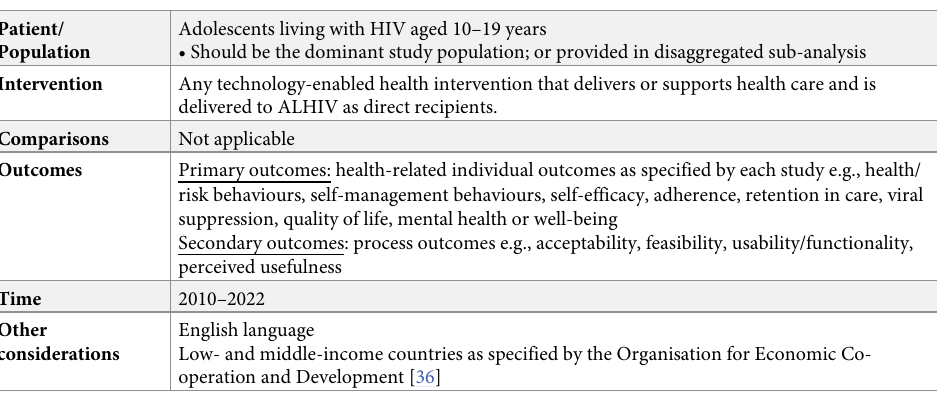
Table 1. PICOT- criteria for inclusion of